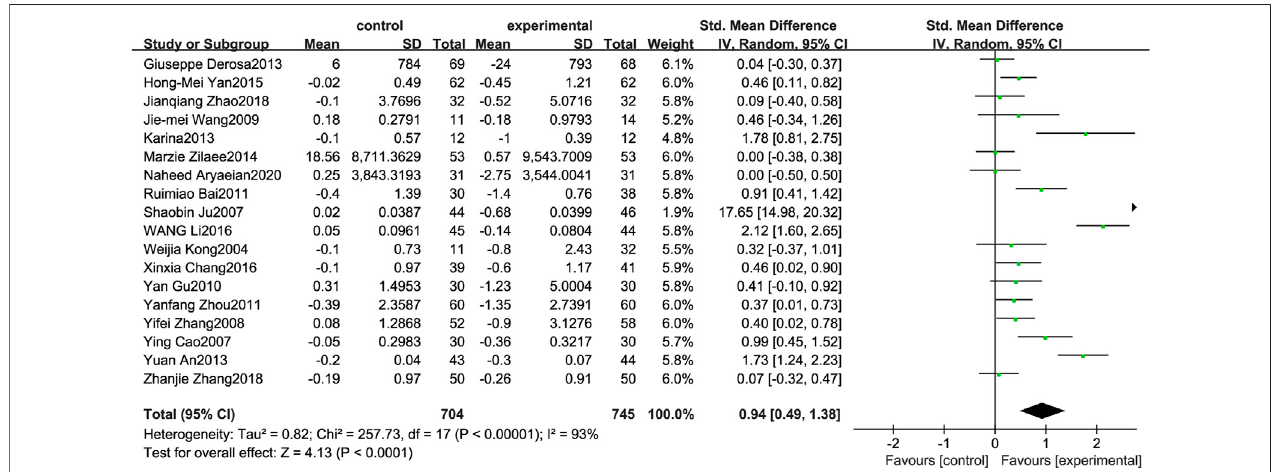
FIGURE 3 | Meta-analysis and migration analysis of the effect of berberine on triglyceride. Forest plot illustrates the differences in changes in triglyceride in adults with metabolic disease who did or did not receive berberine in 15 trials ( n (cid:1) 1,231). The mean difference (blue squares), 95% CI (horizontal lines through blue squares), and pooled-effect sizes (green diamonds) were presented using random-effect Hedges models.